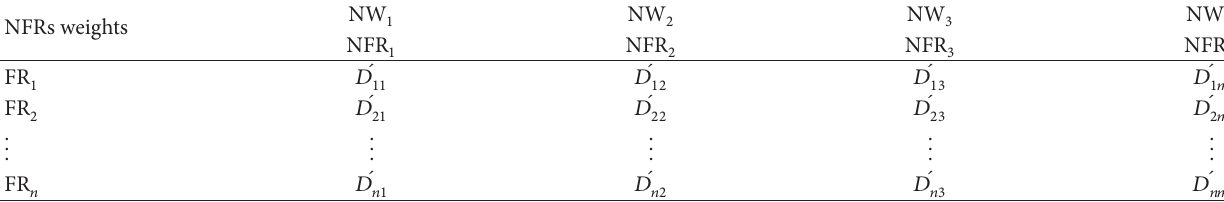
Table 3: Weighted average decision matrix for priority assessment of FRs.